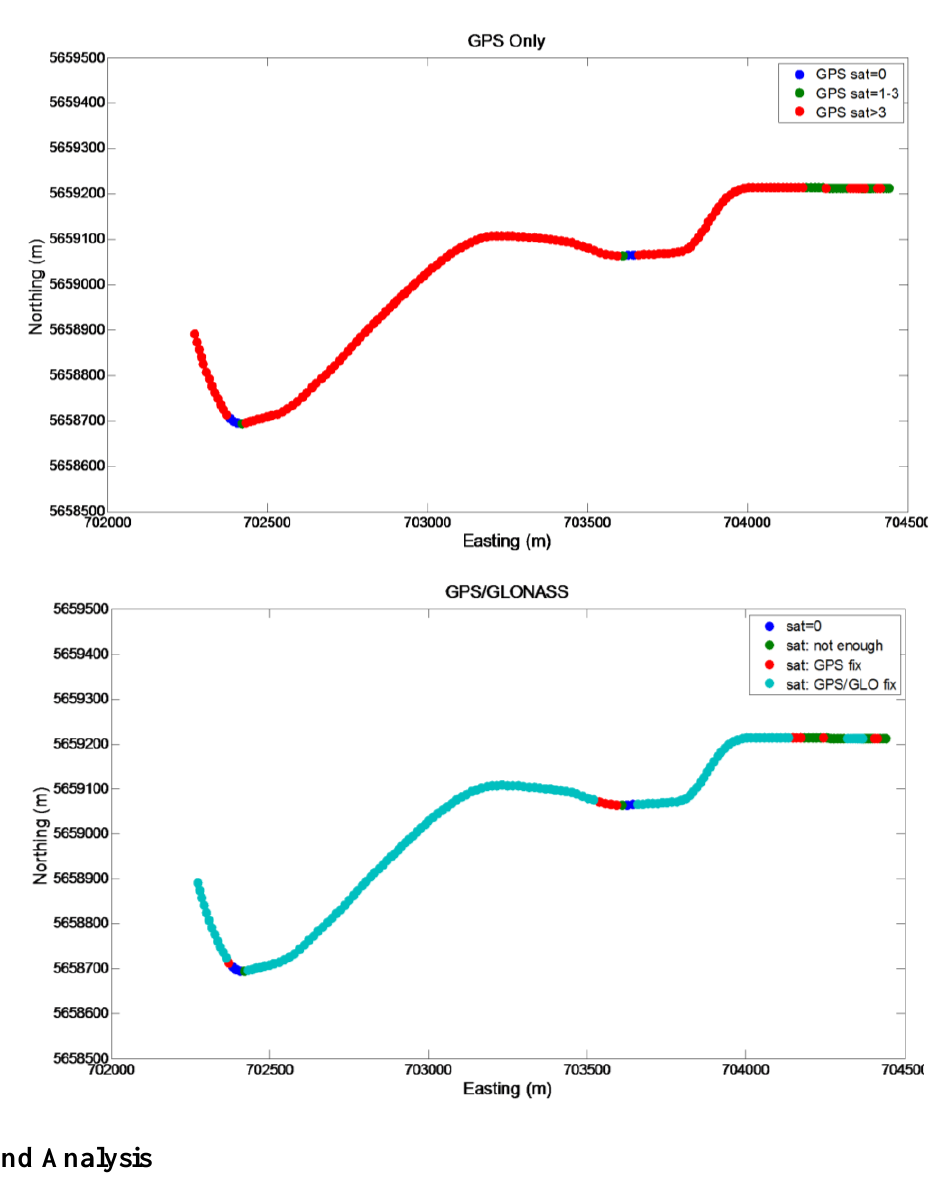
Figure 9. GNSS visibility on the Segment 3